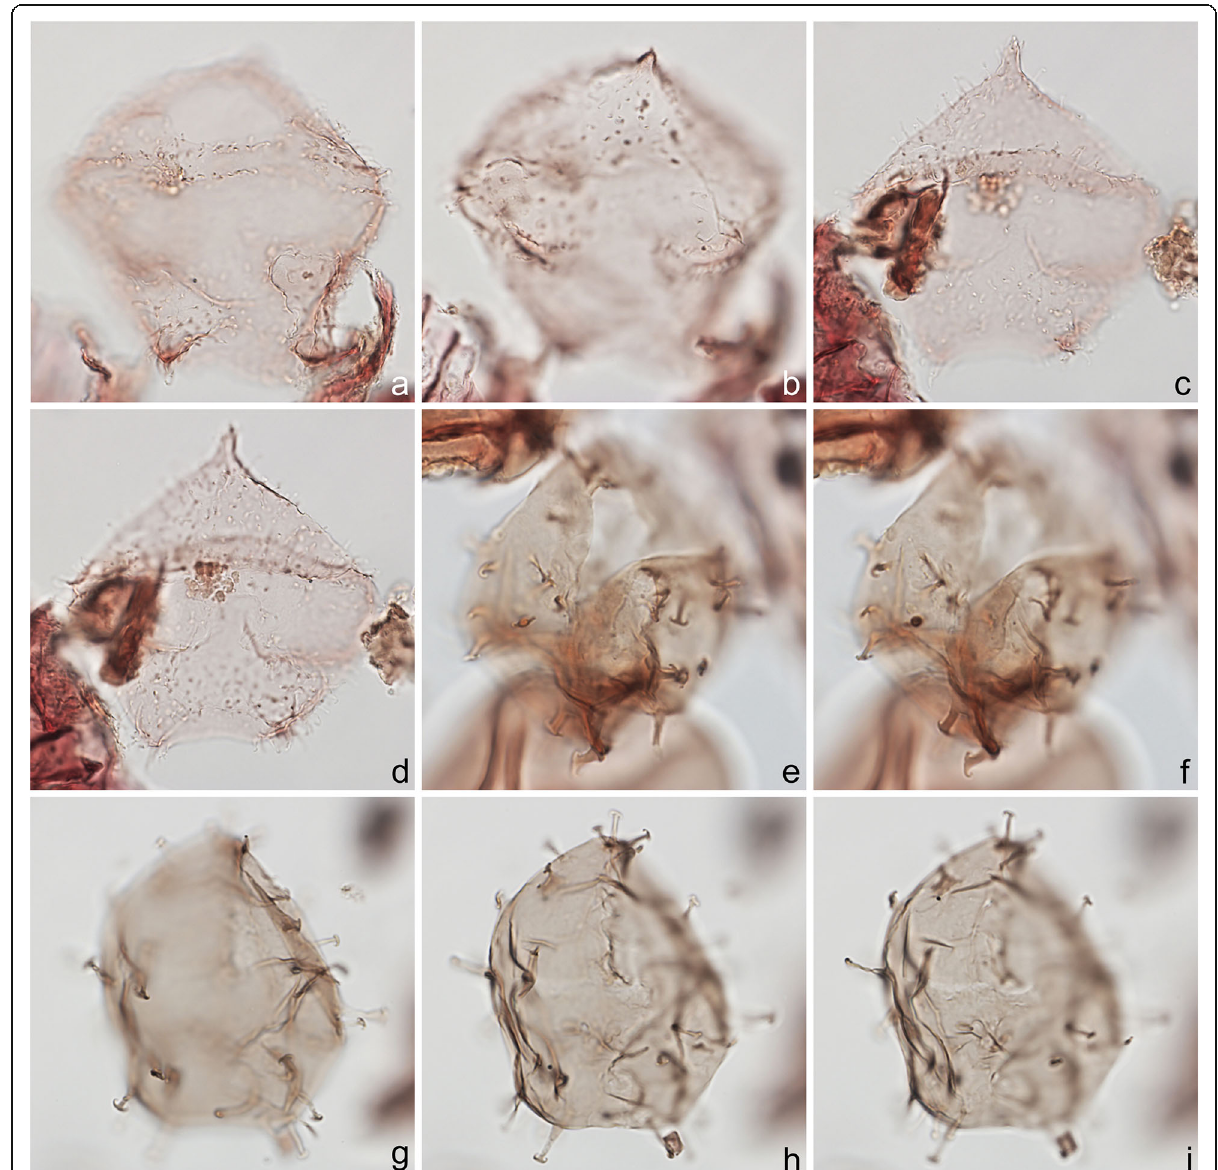
Fig. 12 Dinoflagellate cysts from the Chiba composite section. Max. dia. = maximum diameter. EF = England Finder reference. a – d Trinovantedinium applanatum ; a , b dorsal view at upper and lower foci; central body max. length 71 μ m, width 72 μ m; sample TB2 97, slide 2 (10 μ m) MJH, EF L28/0; c , d dorsal view at upper and mid-foci; central body max. length 72 μ m, width 67 μ m; sample TB2 97, slide 2 (10 μ m) MJH, EF Q24/2. e – i Trinovantedinium cf. harpagonium showing flattened bifurcate process terminations with strongly recurved tips; e , f ventral view at mid- and slightly lower focus; central body length 57 μ m, width 50 μ m; sample TB2 97, slide 4 (20 μ m) MJH, EF G15/0; g – i ventral view at upper through lower foci; central body length 49 μ m; sample TB 92, slide 1 (10 μ m), EF 3.1 Dinoflagellate cyst assemblage biozone 1 (Df1) Samples: TB 145 – 92; depth − 14.5 to − 9.18 m ( − 12.25